Question: Express in one sentence what the figure is showing.
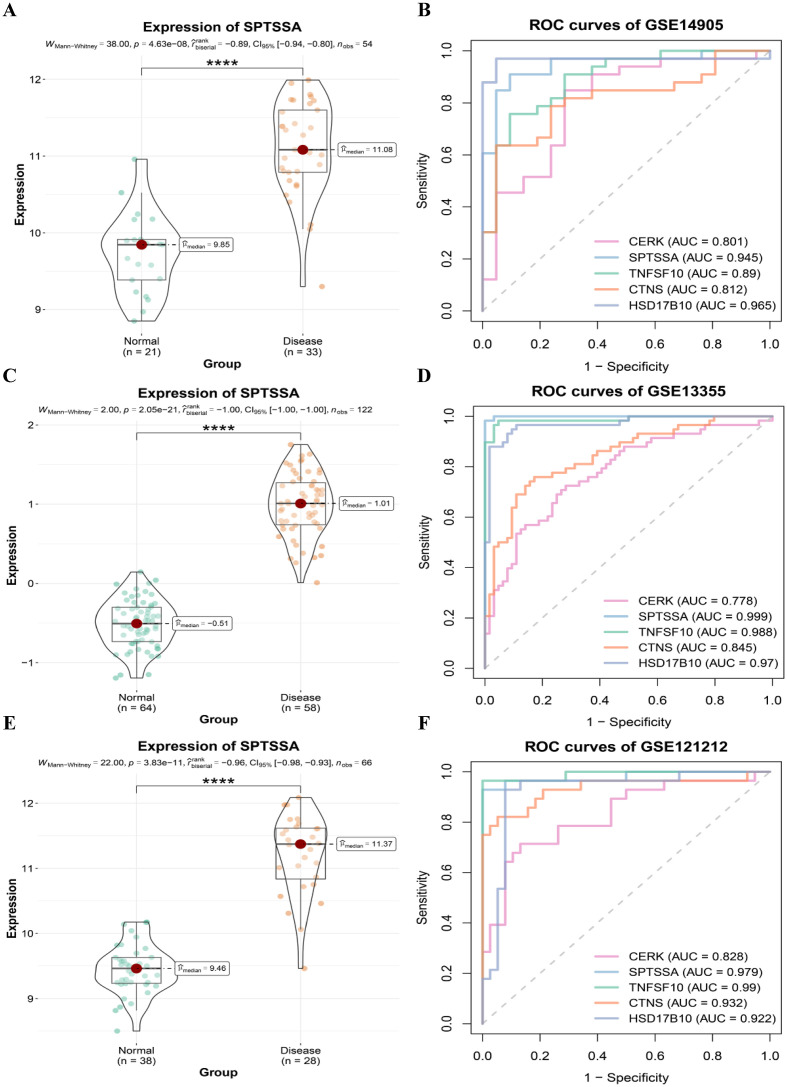
Answer: Cross-cohort validation of candidate hub genes. (A) Differential expression of candidate genes in GSE14905 . (B) ROC curves in GSE14905 . (C) Differential expression in GSE13355 . (D) ROC curves in GSE13355 . (E) Differential expression in GSE121212 . (F) ROC curves in GSE121212 . ****P < 0.0001.